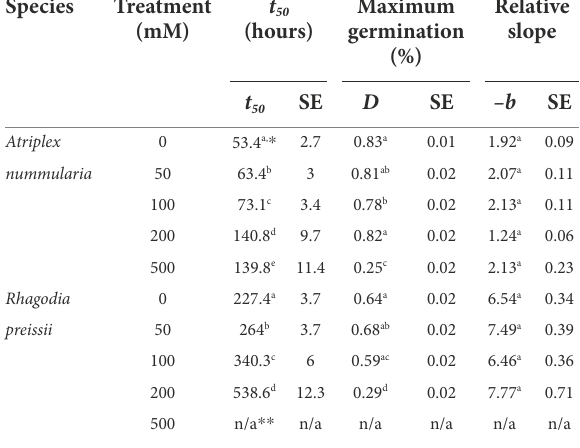
TABLE 4 Salinity experiment 2B: influence of salinity level on seed germination of A. nummularia and R. preissii at five different salinity levels, expressed by the estimated parameters and associated standard error (SE) from the log-logistic model (1) applied to the data. Species